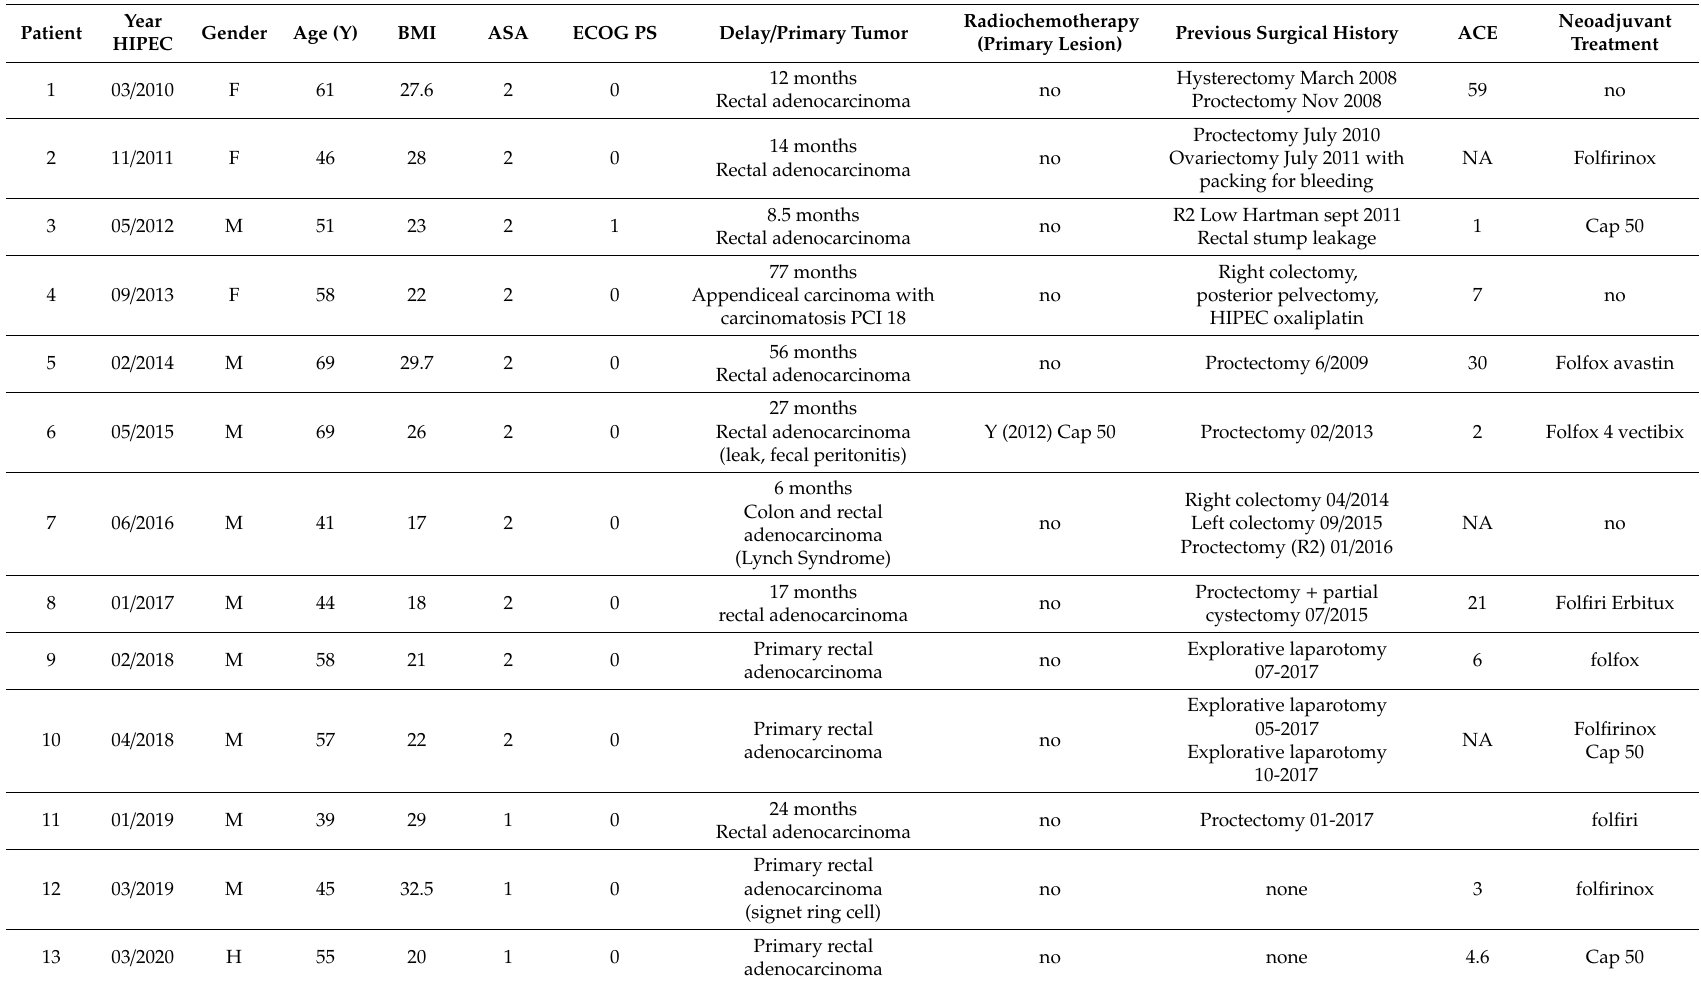
Table 1. Baseline patient